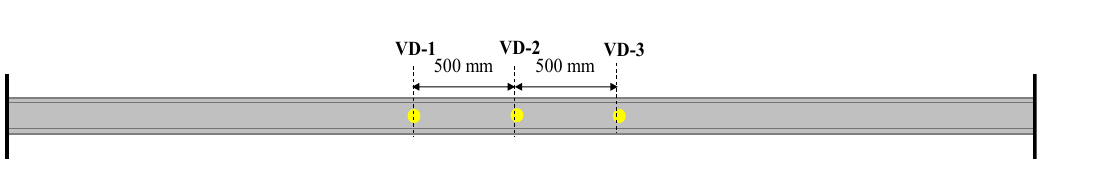
Figure 19. Measuring points for z -axis displacement over time.